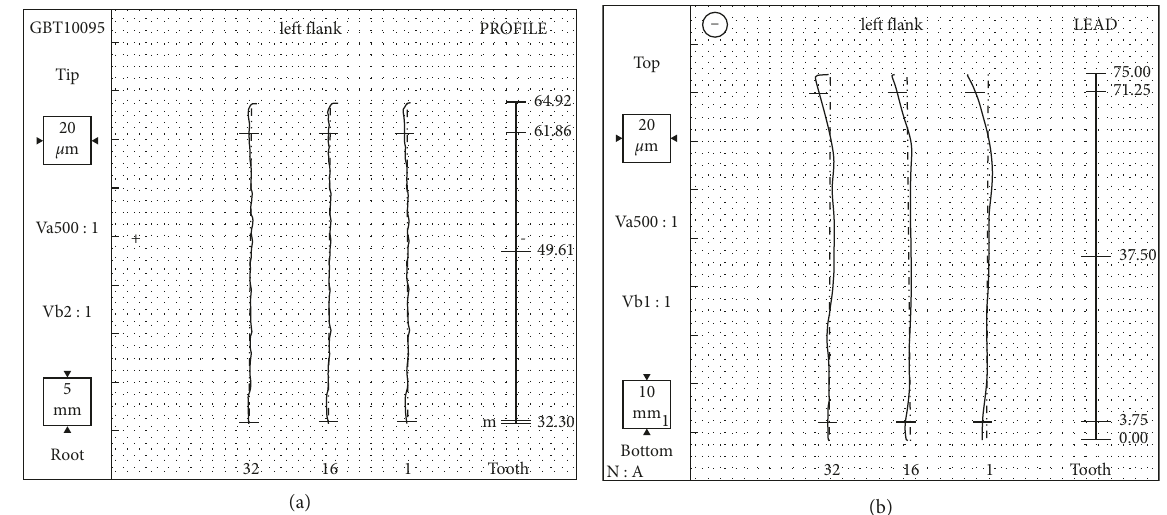
Figure 3: Tooth surface deviation of gear: (a) profile deviation along meshing line direction; (b) lead